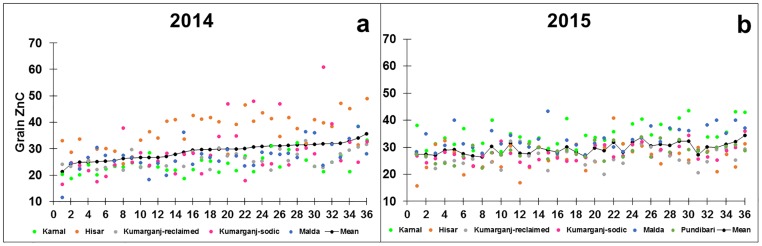
Grain Zn concentration in a panel of 36 genotypes, averaged across five sites in 2013–14 and six sites in 2014–15.Data represent the means of two replicate plots per genotype at Karnal, Hisar and Malda, and one replicate per genotype at Kumarganj-reclaimed and Kumarganj-sodic sites in 2013–14, and the means of two replicate plots of each genotype at all six sites in 2014–15. Genotypes 1–36 are labelled in the same order in both years on the x-axis: 1) HW 2044; 2) HD 2932; (3) RW 3684; (4) WH 1021; (5) HD 2967; (6) DBW 46; (7) KRL 1–4; (8) GW 322; (9) NW 4092; (10) GW 322; (11) NW 4092; (12) PDW 314; (13) RAJ 4229; (14) MACS 6222; (15) DPW 621–50; (16) WH 1105; (17) HI 1563; (18) KRL 210; (19) DBW 71; (20) NW 1067; (21) NW 4018; (22) DBW 14; (23) KRL 213; (24) HI 8498; (25) BH 1146; (26) DBW 51; (27) KRL 19; (28) UP 262; (29) DBW 17; (30) K 0307; (31) HD 2009; (32) HD 2733; (33) RAJ 4238; (34) DBW 39; (35) KRL 3–4; (36) Kharchia 65.